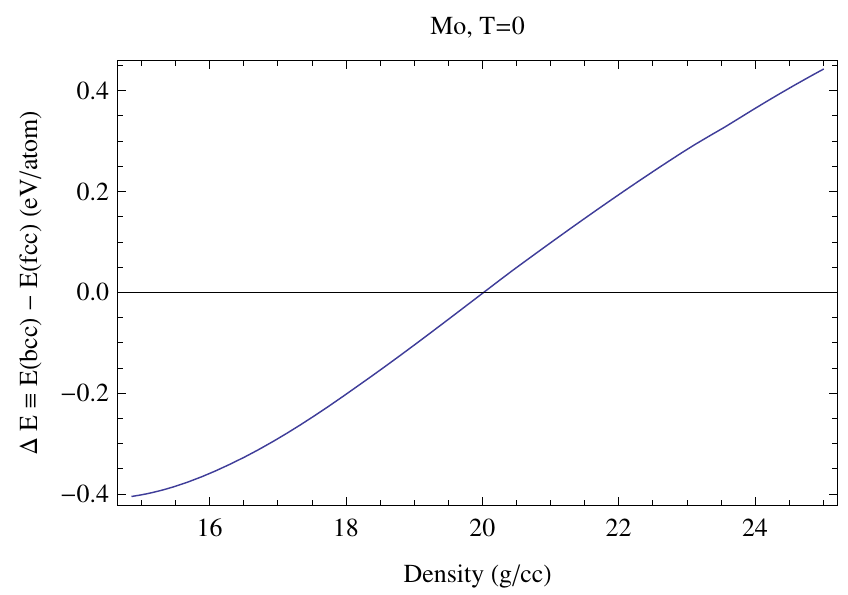
Figure 6. The T = 0 bcc-Mo–fcc-Mo total energy difference as a function of density.